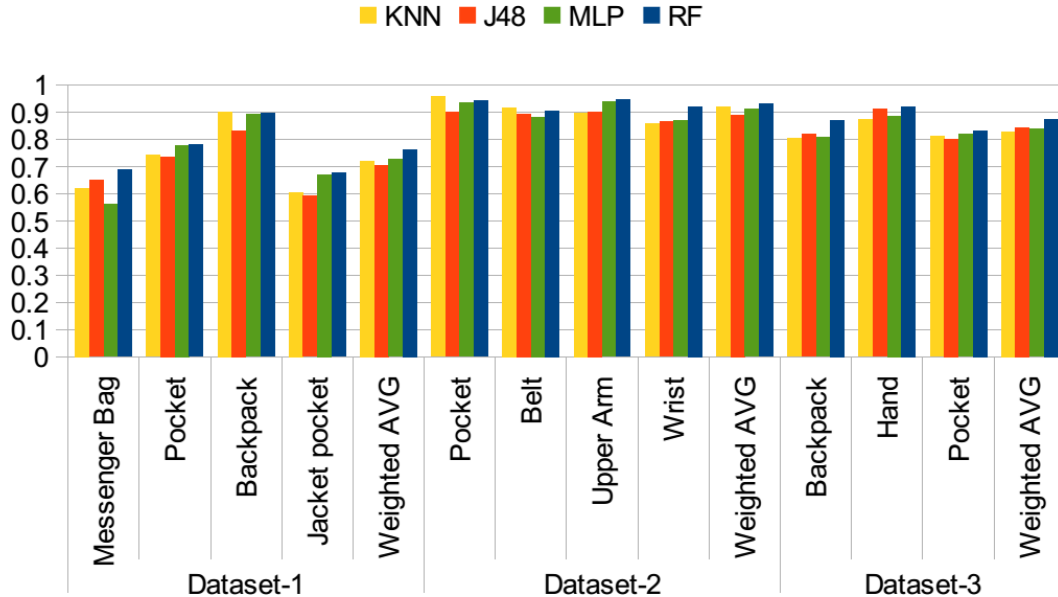
Figure 6. Position recognition performance with all